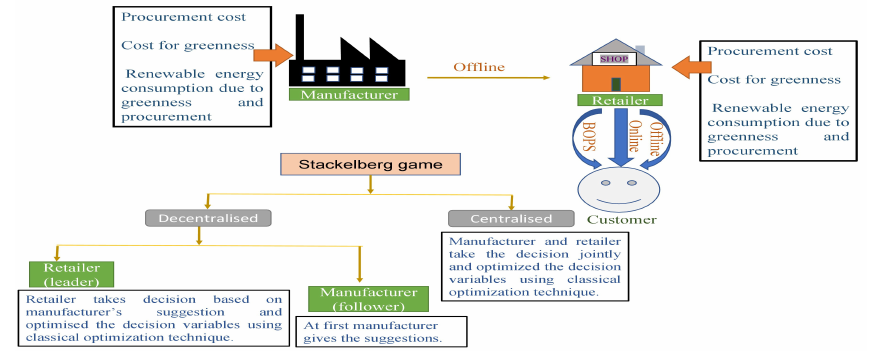
Figure 1. Graphical representation of Model 1 and research